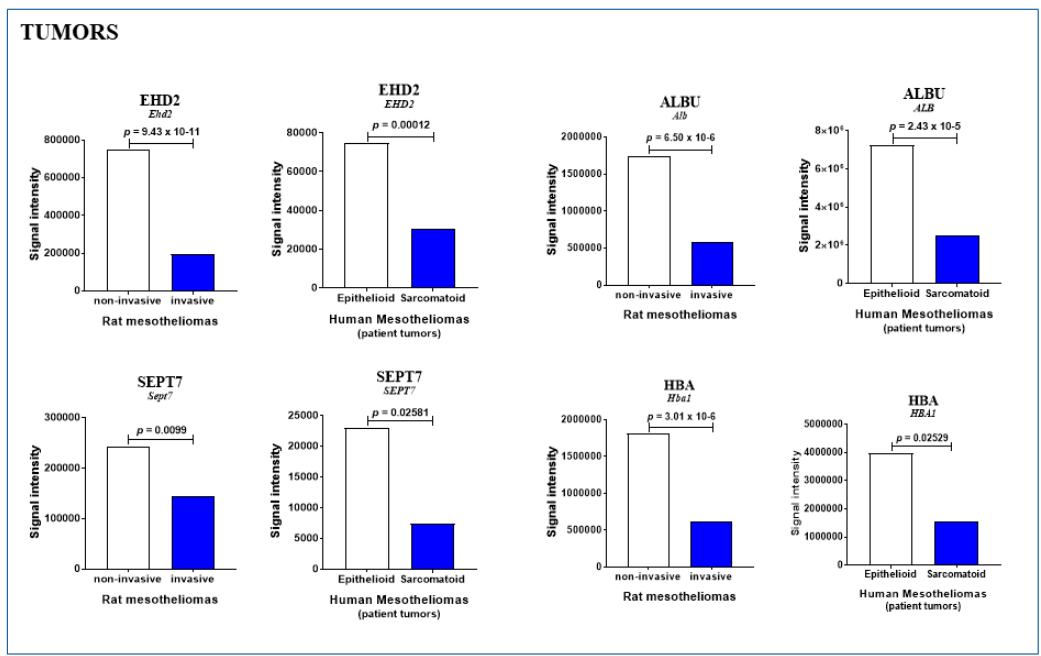
Figure 5. Additional invasiveness biomarkers in MM from patient and rat models. Proteins showing comparable abundance changes only in patient MM vs. rat models. Increase and decrease are indicated by red and blue bars, respectively (with p values). Blank bars reflect the absence of significant changes ( p > 0.09). For clarity, data on the beta subunit of hemoglobin (encoded by HBB ) have been excluded as they were similar to those observed for the alpha subunit (encoded by HBA ).